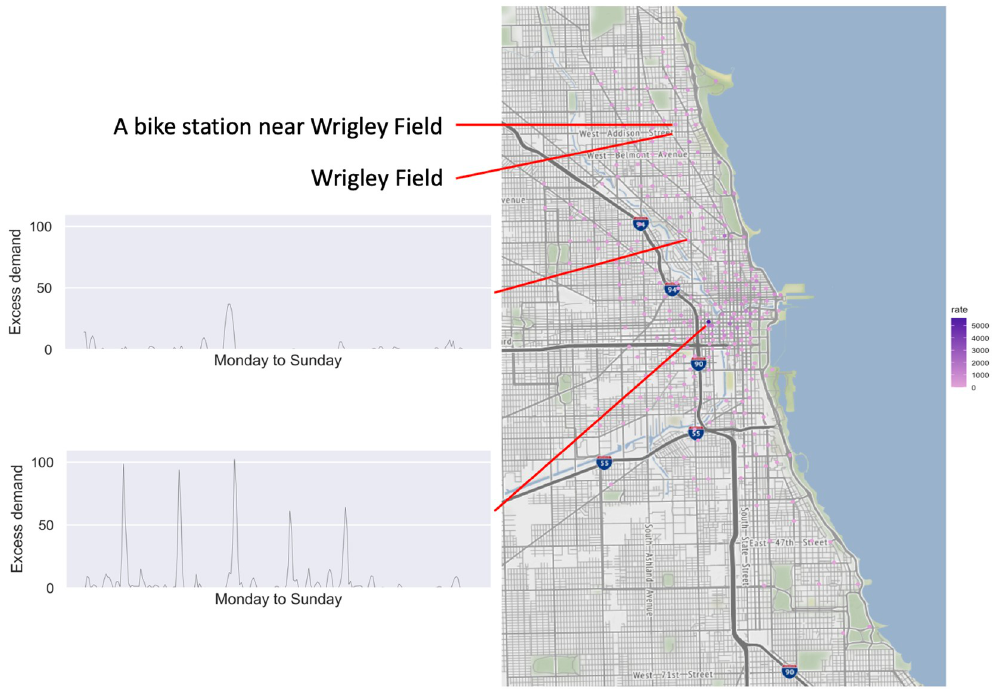
Fig 8. Cumulative dock excess demand rate for different stations. Reprinted from [40] under a CC BY license, with permission from OpenStreetMap, original copyright 2021.